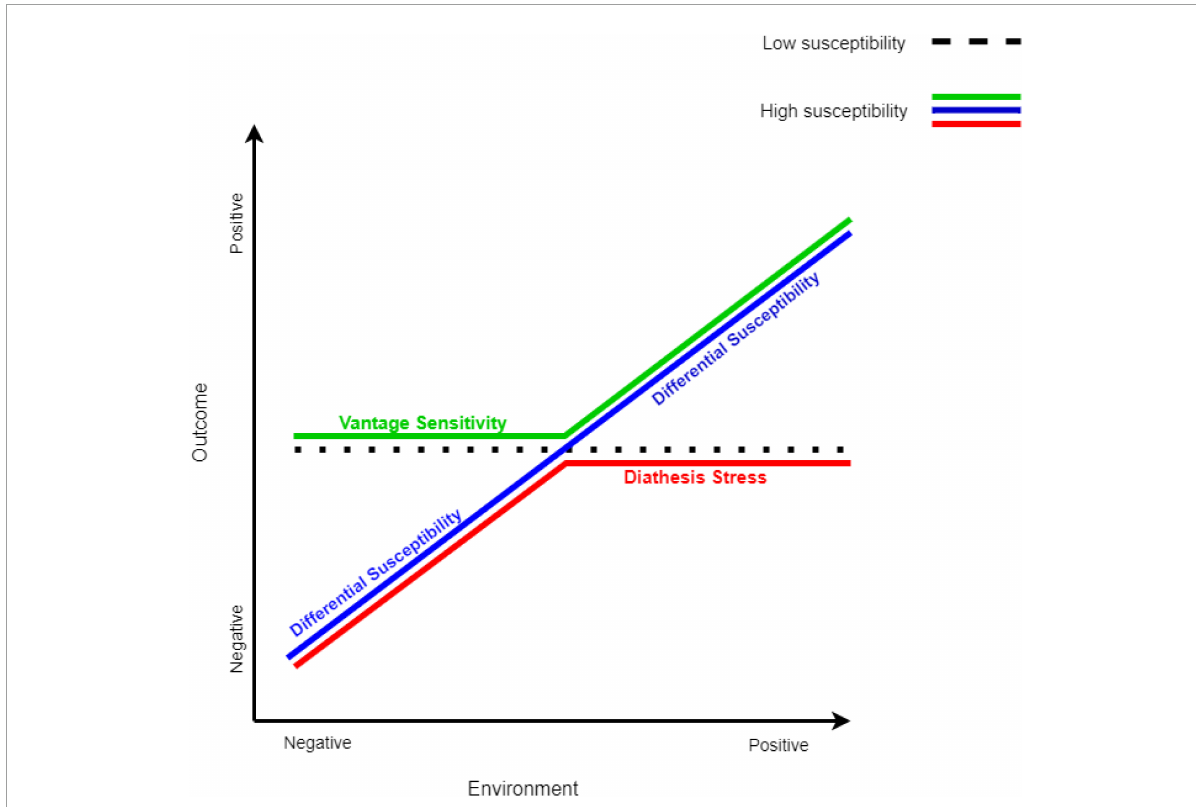
FIGURE1 Models of sensitivity to the environment. The models of sensitivity to the environment are adapted from Bakermans-Kranenburg and van IJzendoorn (155). All three models predict that non-susceptible individuals are not affected by the environment (dotted black line). The red line represents susceptible individuals according to the diathesis-stress model, the green line represents susceptible individuals according to the vantage sensitivity model, and the blue line represents susceptible individuals according to the differential susceptibility